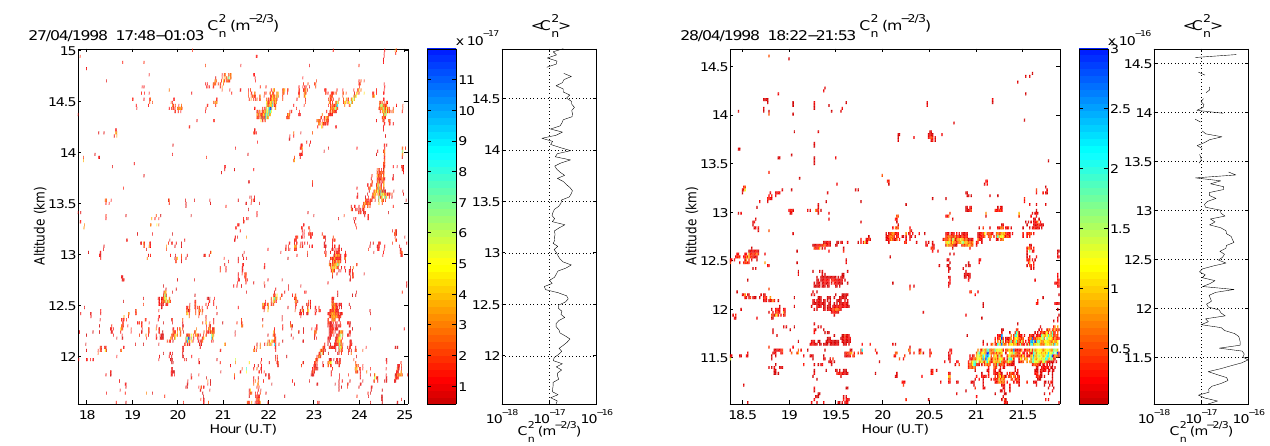
Fig. 2. Left panel: Height-Time distribution of C 2 n on 27 April 1998. Right plot: Averaged C 2 n within the turbulent patches.